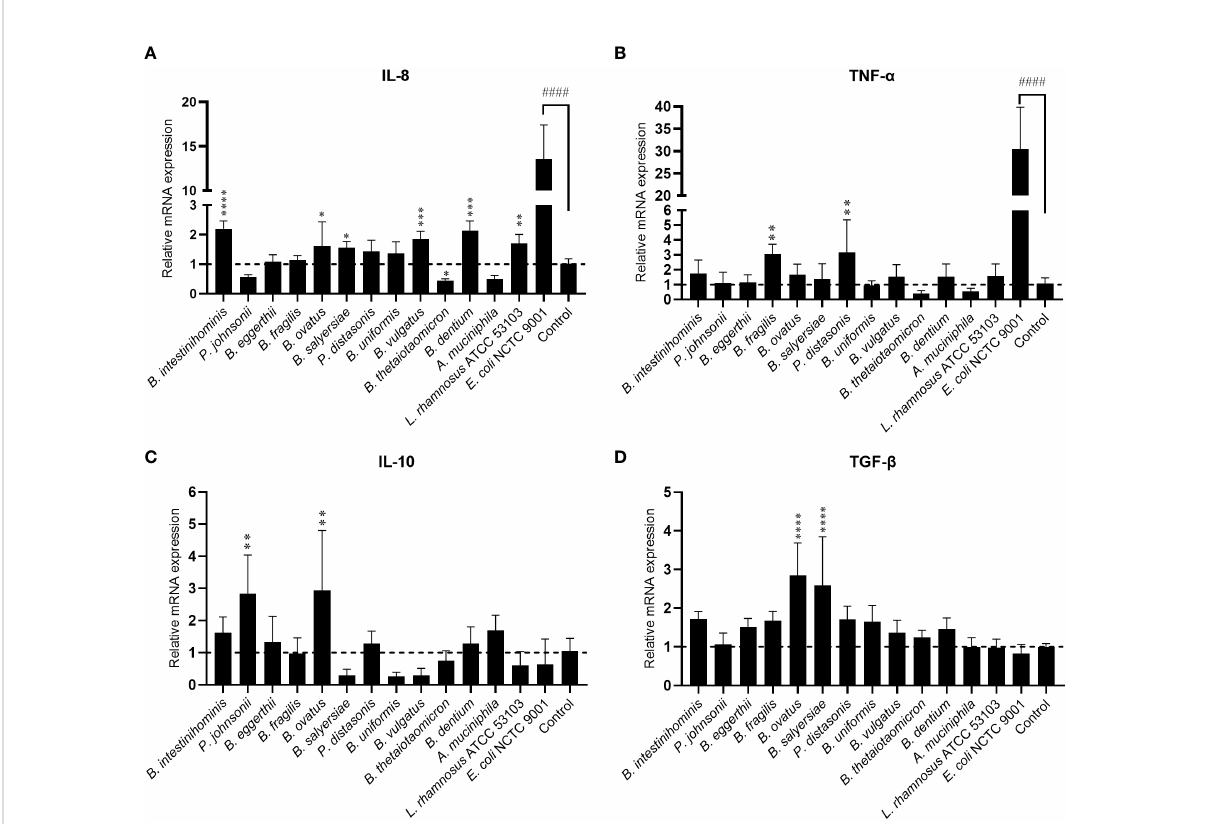
FIGURE 2 Effects of mucin-degrading gut commensals on the mRNA expression of IL-8 (A) , TNF- a (B) , IL-10 (C) and TGF- b (D) in HT-29 after 2-hour co- culture. L. rhamnosus ATCC 53103 and pathogenic E. coli NCTC9001 were included in the experiments as control strains. #### p < 0.0001 compared to the control group; * p < 0.05, ** p < 0.01, *** p < 0.001, **** p < 0.0001 compared to the E. coli NCTC9001 group as determined by one-way ANOVA followed by Dunnett ’ s test for multiple